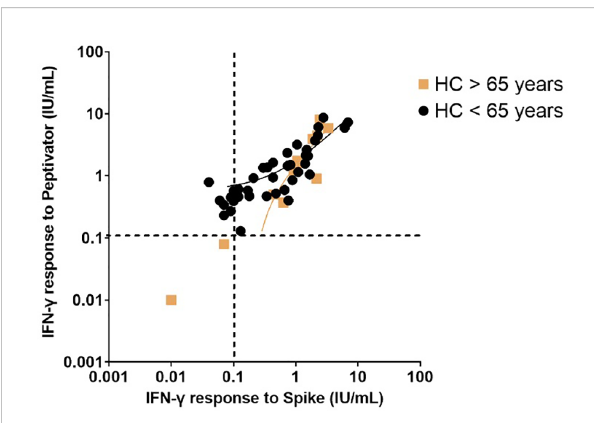
FIGURE 2 Interferon-gamma response to peptide mix stimulation compared to spike protein stimulation in healthy controls post primary vaccination strati fi ed by age (greater than 65 years compared to less than 65 years). Individual values are plotted on a logarithmic scale (log 10). The dashed line represents the limit of the validated reference range (0.11IU/ml). The solid lines depict the lines of regression.